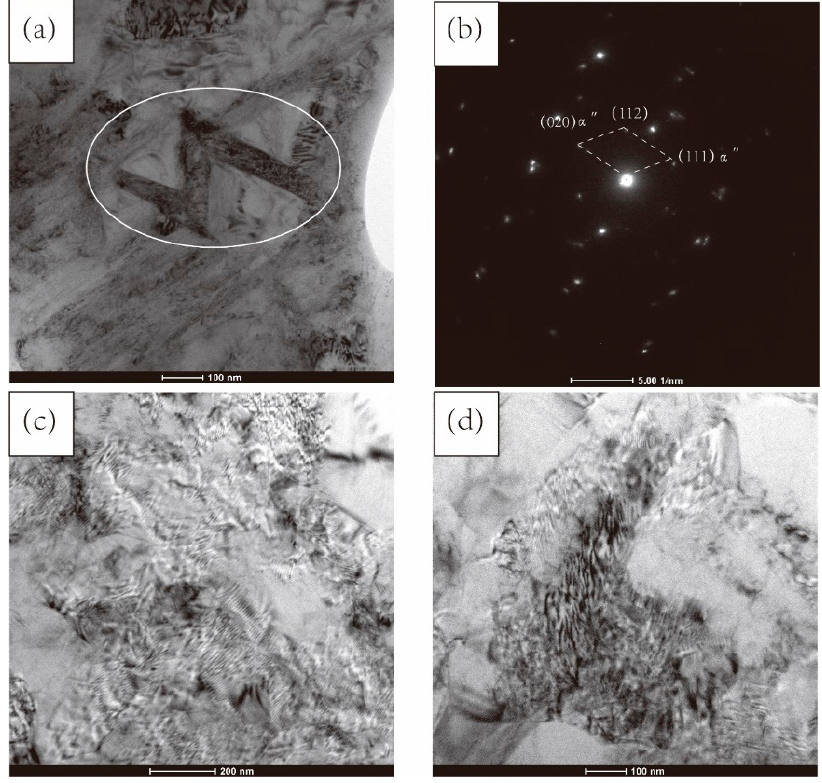
Figure 6. TEM image of TC4 alloy after one cycle of MDIF: ( a , b ) one pass; ( c ) two passes; ( d ) three passes.